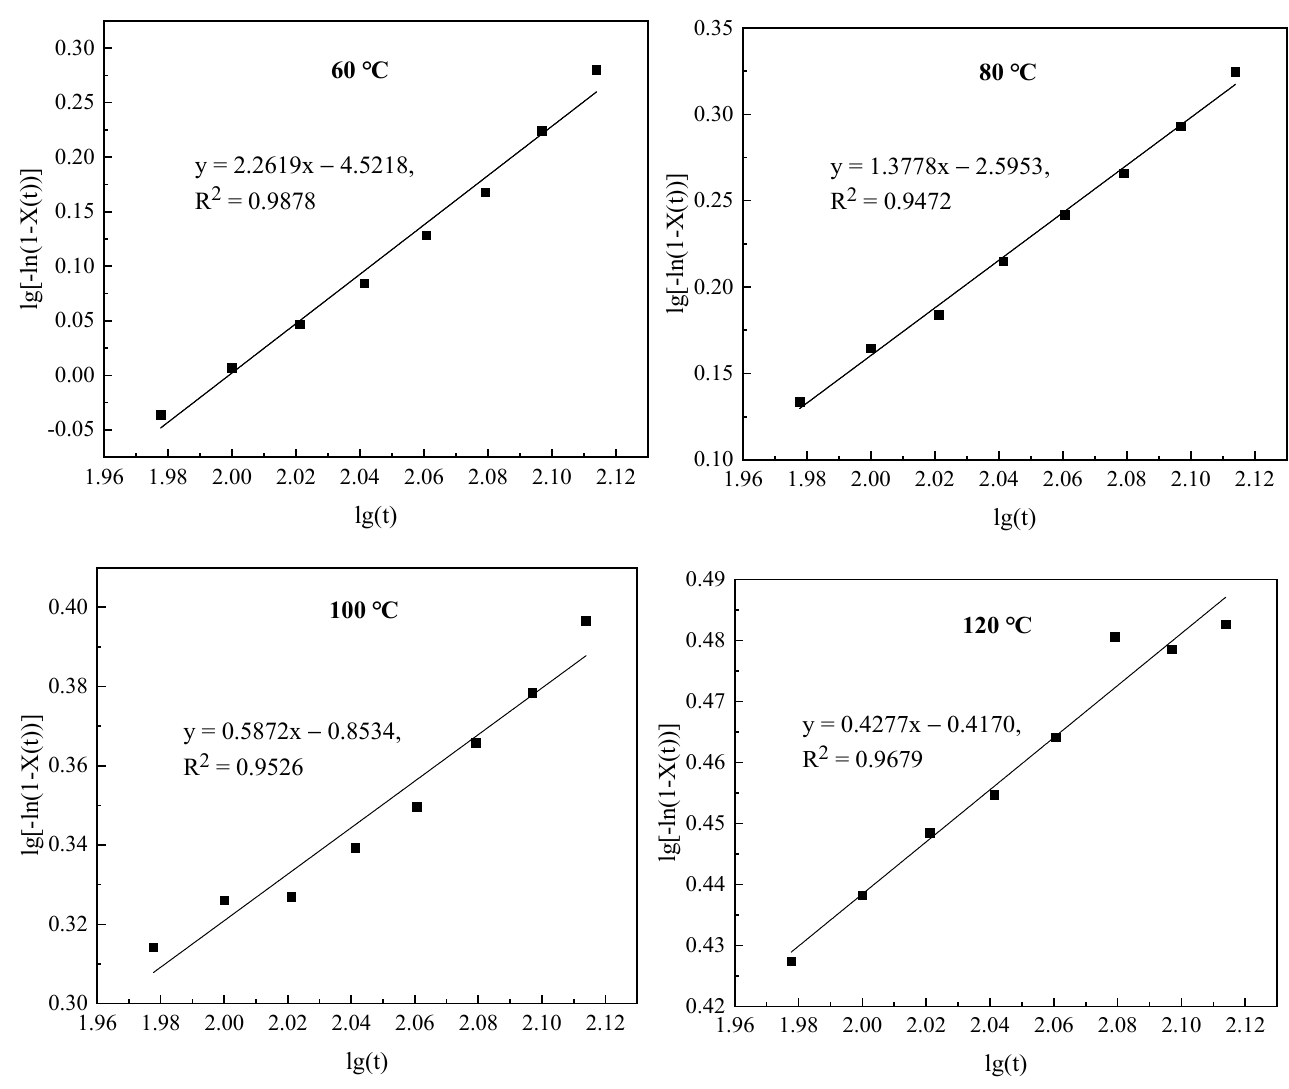
Figure 7 is obtained by fitting the Avrami kinetic data in Table 5. As shown in Figure 6, when the precipitation time is in the range of 95–130 min, and the vanadium precipitation temperature is 60–80 °C, the crystallization and growth process of calcium pyrovanadate can be well-described by Avrami kinetic model.